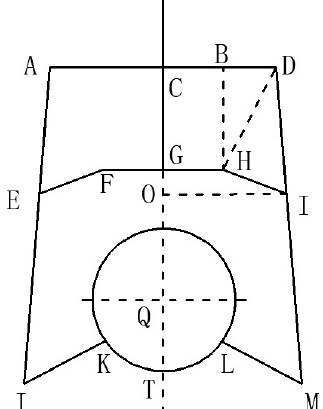
Figure 2. A simplified robot model.